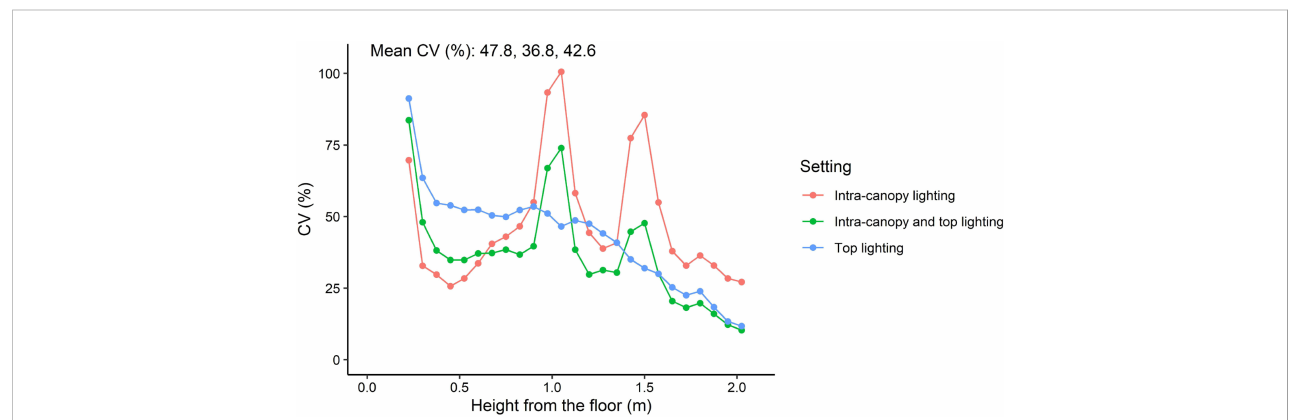
FIGURE 8 Coef fi cient of variation (CV) of absorbed PPFD in relation to height in the canopy. CV relates to the variation within horizontal layers. Each layer is represented by 7.5 cm height and takes all perpendicular and parallel leaves of 48 plants and is shown as a dot in the graph. Mean CV of all horizontal layers is provided in the top left corner for intra-canopy lighting; intra-canopy and top lighting; and top lighting,